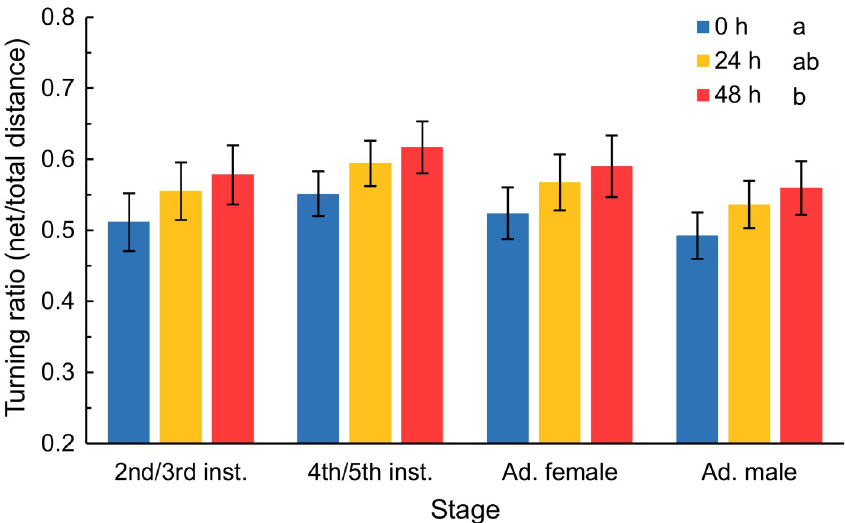
Fig 3. Turning ratio (net distance/total distance) for different stages of bagrada bug that were starved for different periods in the outdoor experiment. Insects were starved for 0, 24, or 48 h. Starvation significant influenced turning ratio across stages. Values were logit transformed for the analysis. Starvation treatments not sharing lowercase letters are significantly different based on posthoc comparisons. Means are back-transformed least-squares means with their 95% confidence